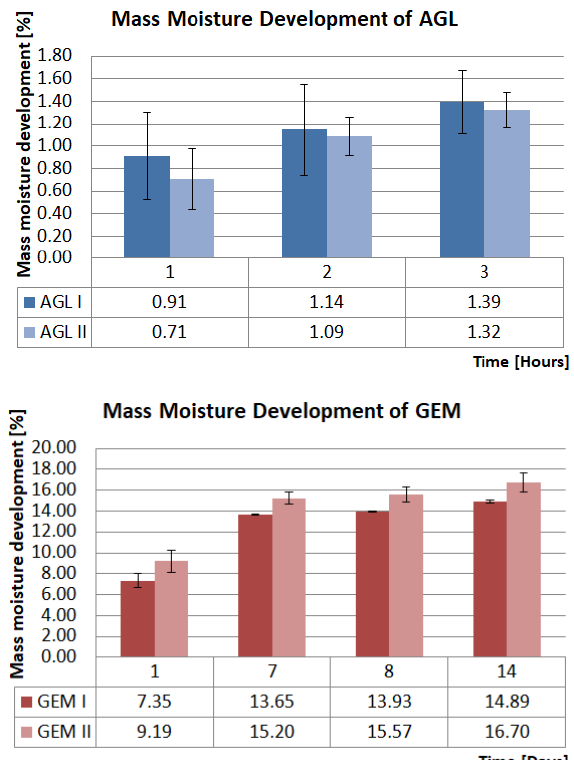
Figure 4. Mass moisture development of prescrip- tions AGL and